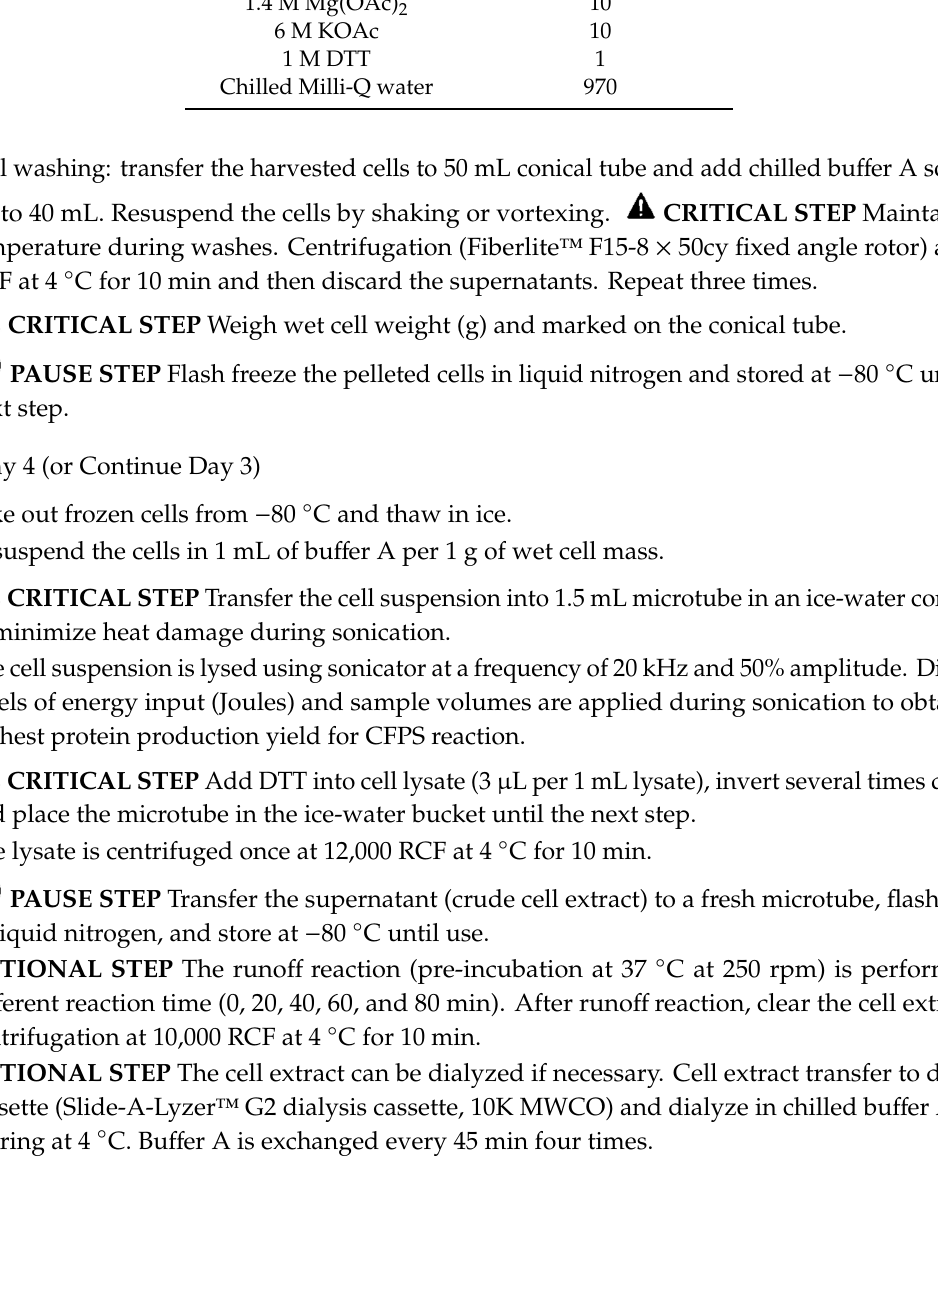
Table 1. The components for 1 L of bu ff er A.